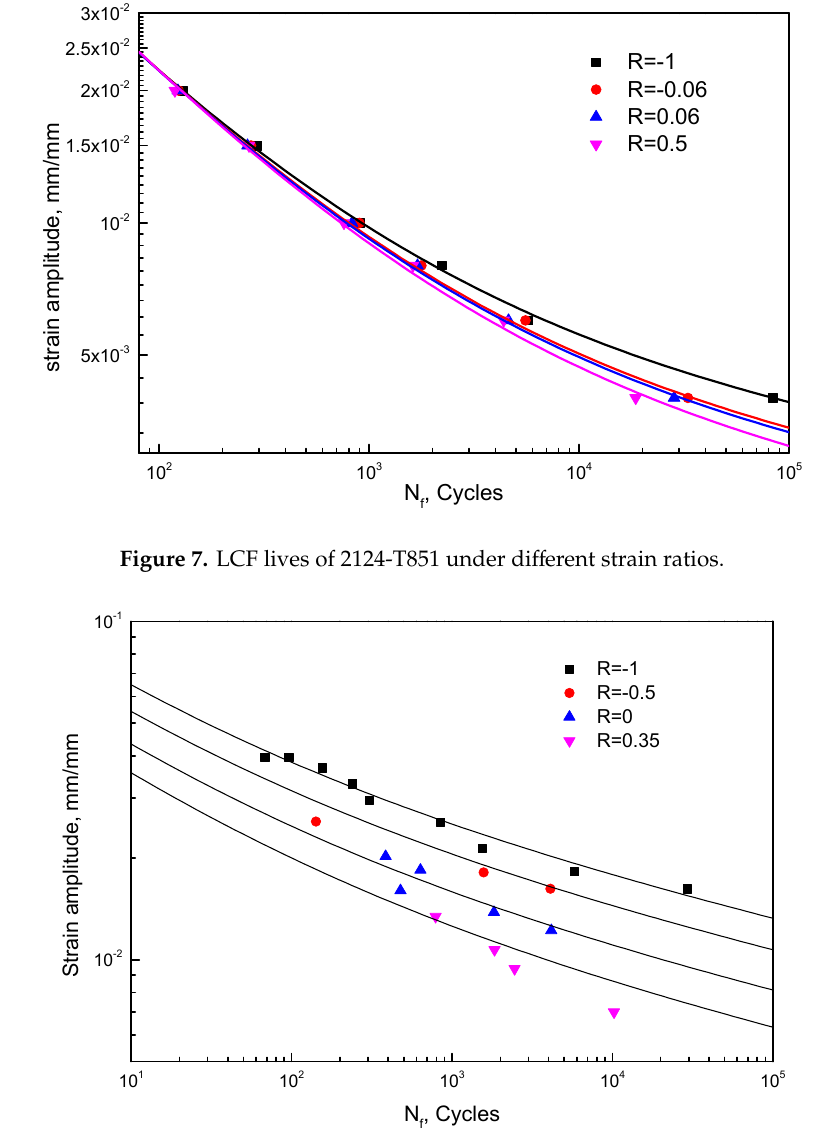
Figure 8. Low-cycle fatigue (LCF) lives of epoxy resin under different strain ratios.